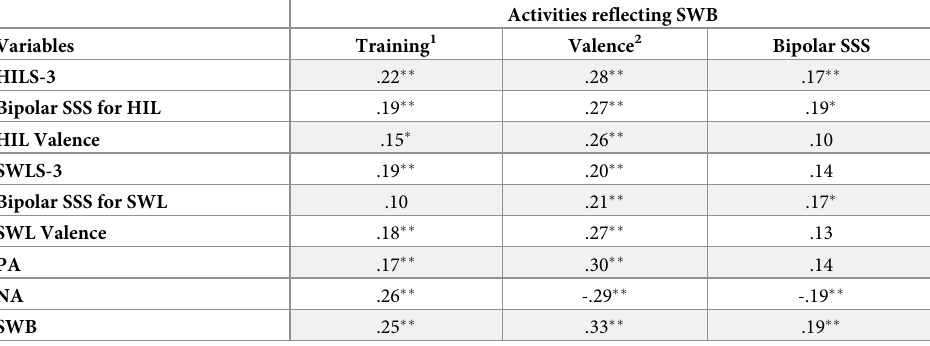
Table 3. Relationship between activities reflecting SWB and various SWB